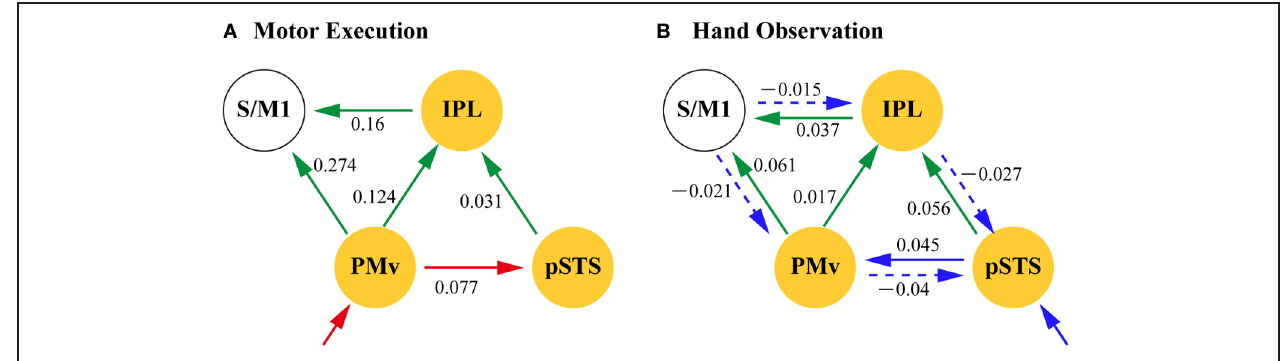
FIGURE 6 | Dynamic modulation of action representation network by motor execution (A) and Hand Observation (B). Network nodes (yellow) are the part of the pMNS (putative mirror neuron system). Arrows indicate significant modulation of the effective connectivity by motor execution (red), hand observation (blue), or both (green).